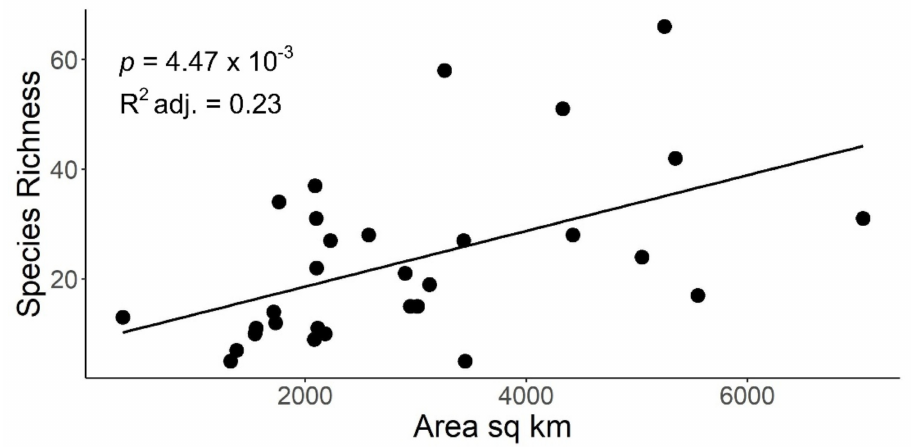
Figure 4. Scatterplot of stonefly species richness versus Indiana HUC8 watershed drainage area in km 2 . Adjusted R 2 , probability, and line of best fit provided for simple linear regression analysis.